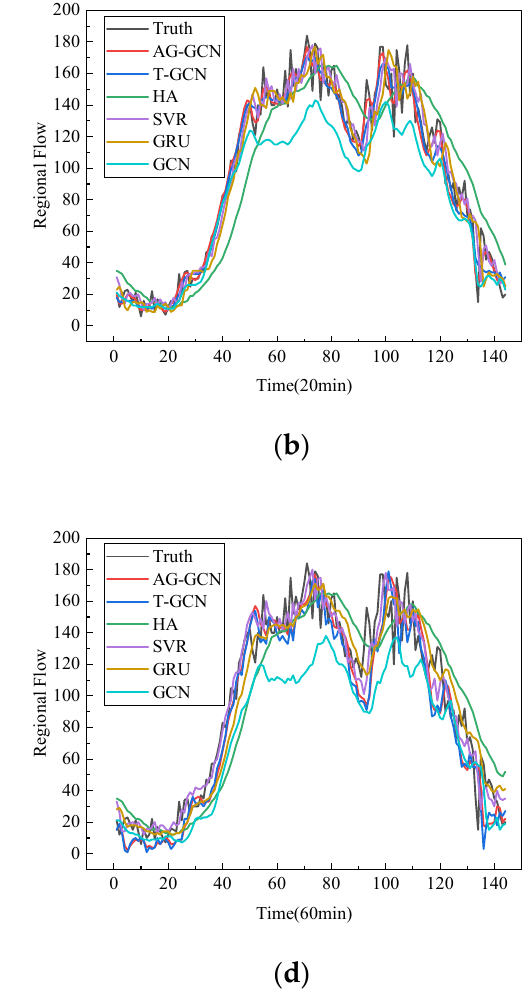
Figure 4. Inflow forecast results of functional areas at different time steps (one day): ( a ) forecast 10 min later; ( b ) forecast 20 min later; ( c ) forecast 30 min later; and ( d ) forecast 60 min later.